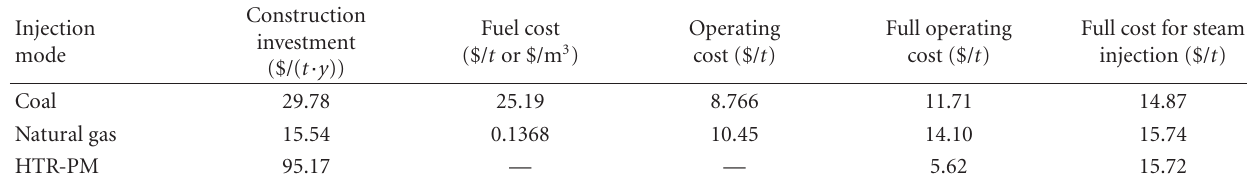
Table 4: Costs of steam injection at lower fossil fuel price and higher bank rate.